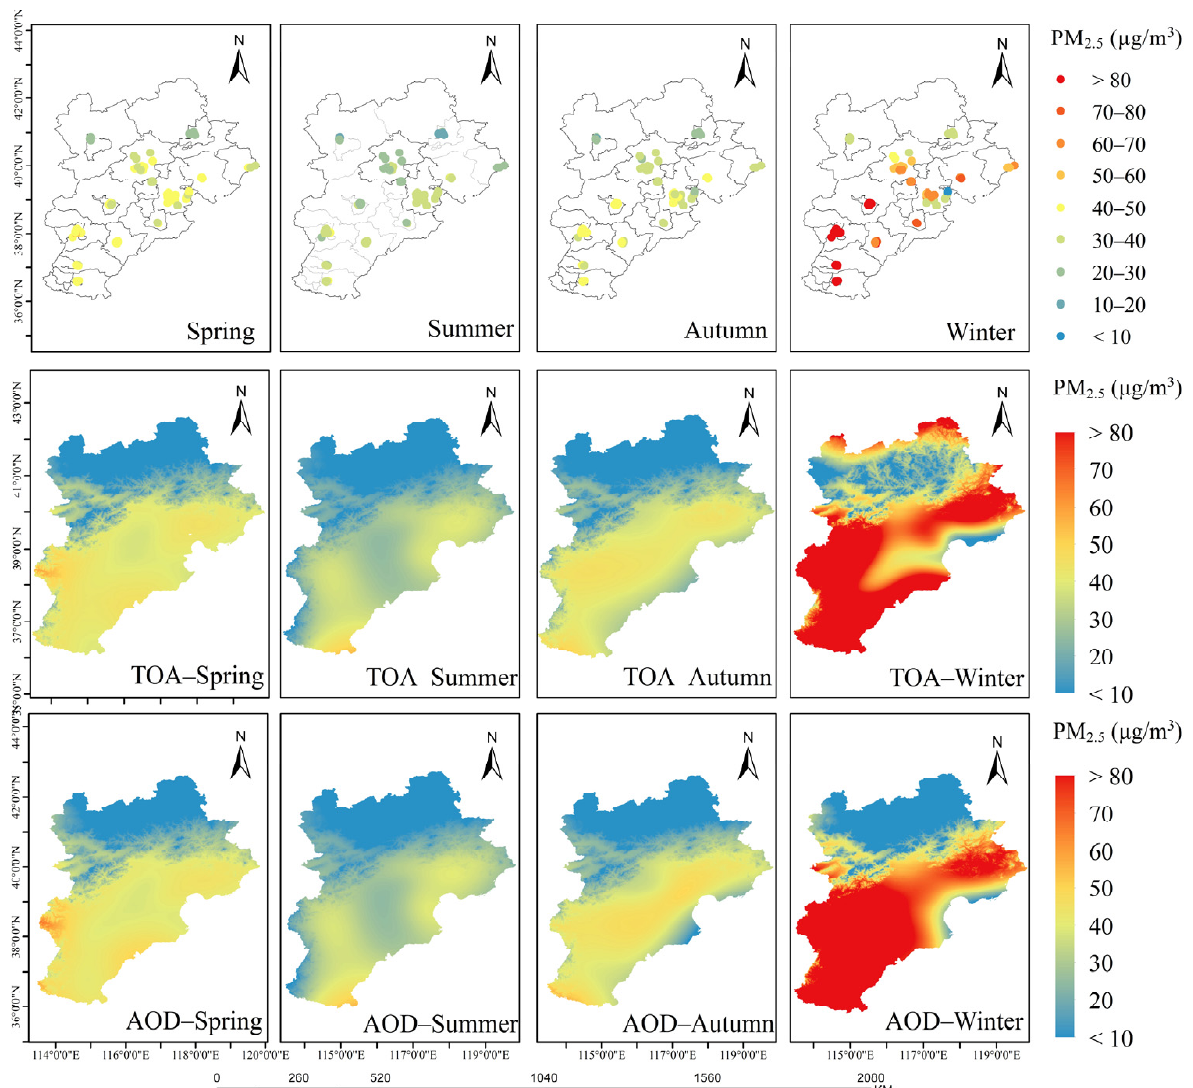
Figure 7. Seasonal average distribution of PM 2.5 concentrations in the Beijing–Tianjin–Hebei re- gion.